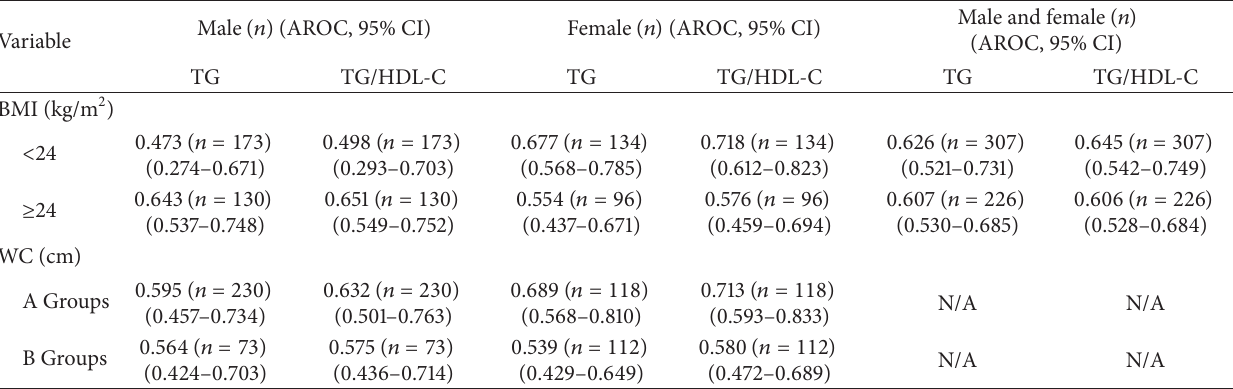
Table 2: Area under receiver operating characteristic curves for discriminating insulin resistance in different subgroups according to body mass index or waist